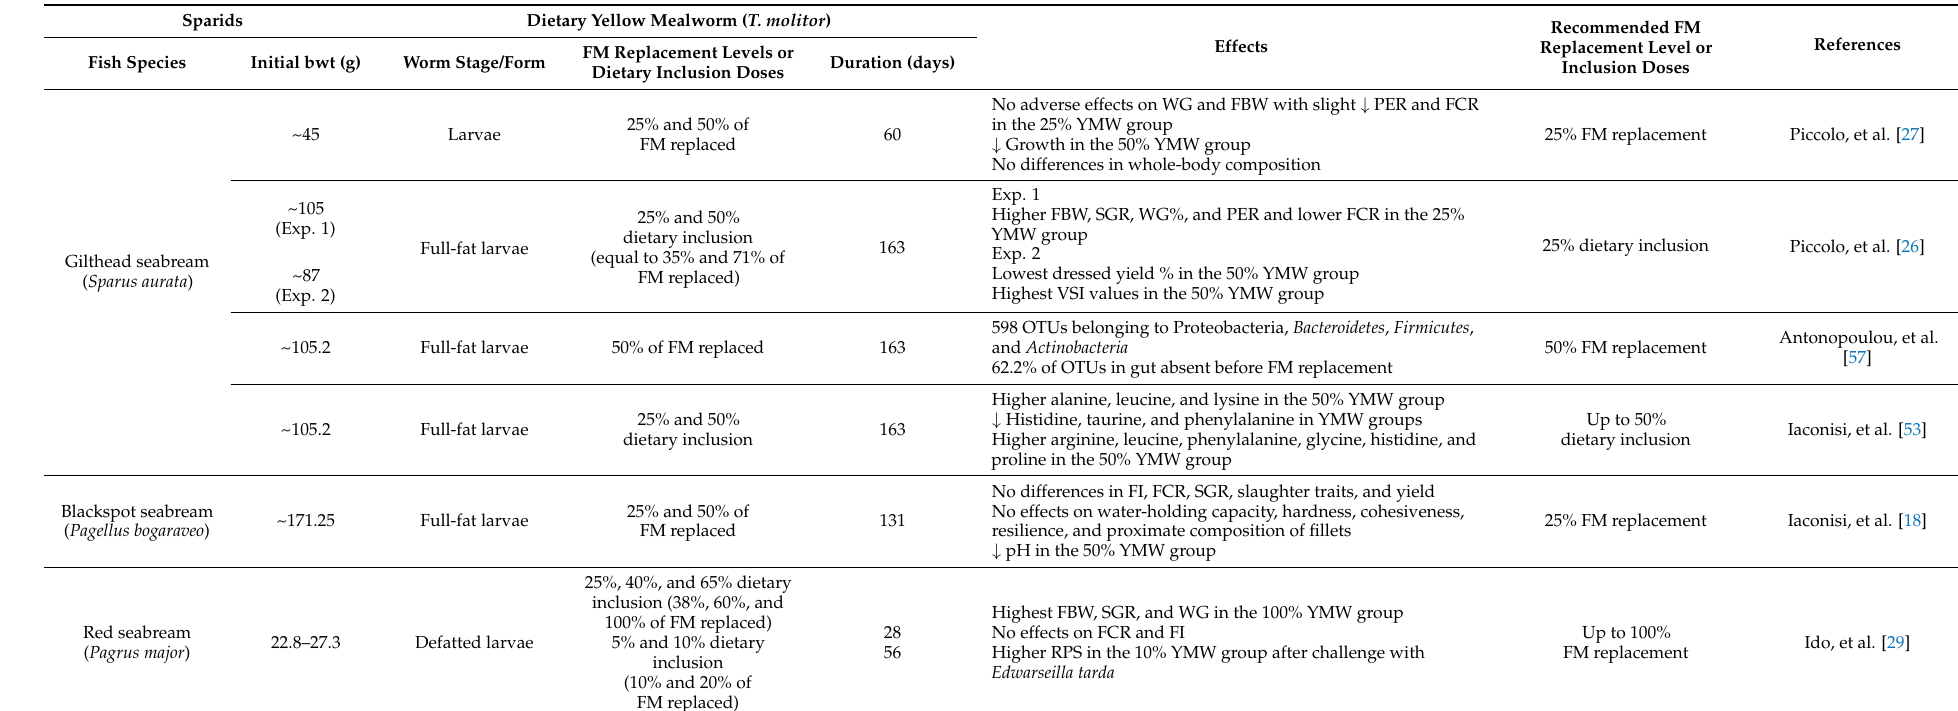
Table 6. Application and effects of using the yellow mealworm ( Tenebrio molitor ) in the diets of sparids (family Sparidae